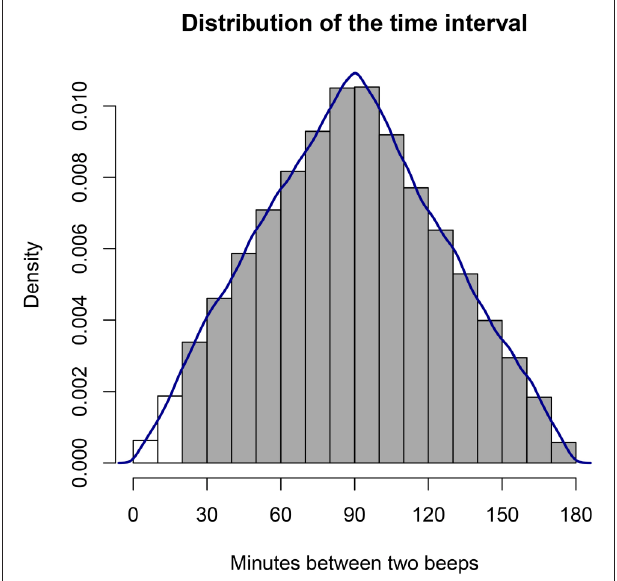
FIGURE 1 | Distribution of the time intervals between consecutive measurements in an ESM study when beeps are uniformly randomly distributed within blocks (here, a block equals 90 min). In practice, it may be desirable to impose a minimum time interval, effectively truncating the